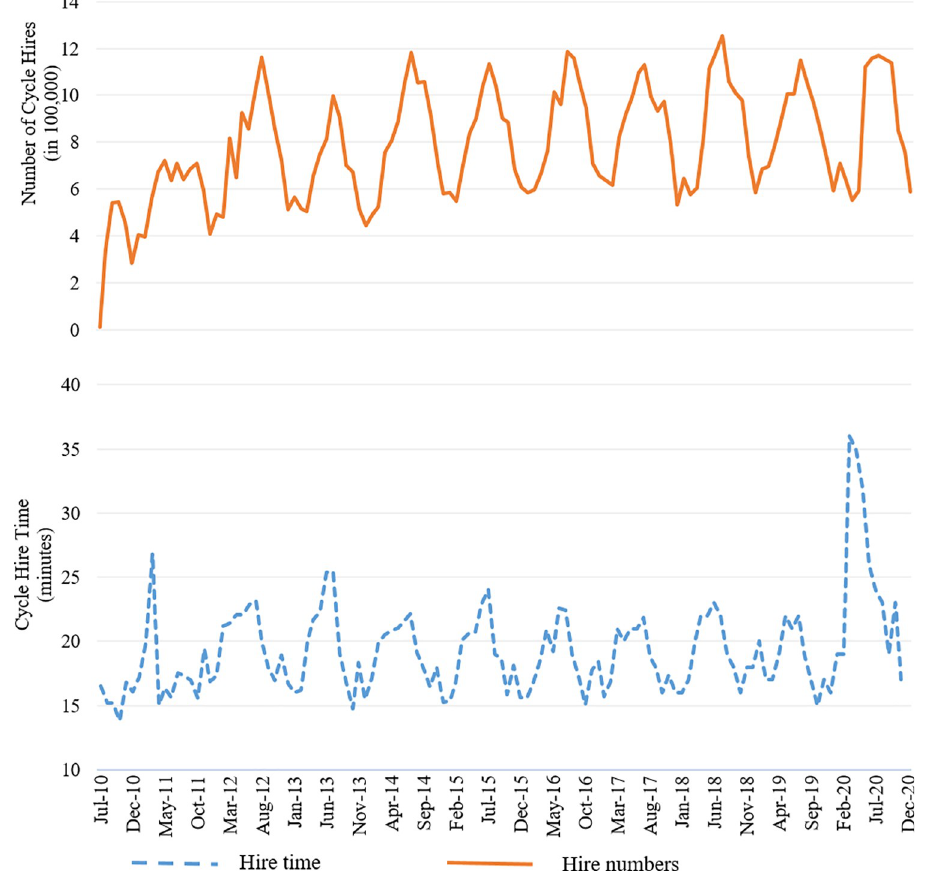
Fig 1. London bike-share time-series of monthly hire numbers and average monthly hire